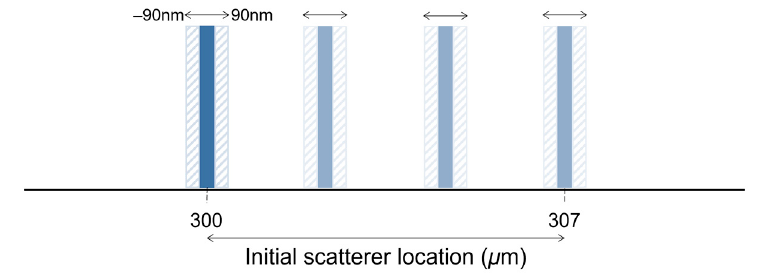
Figure 2 . Simpli fi ed representation of the displacement